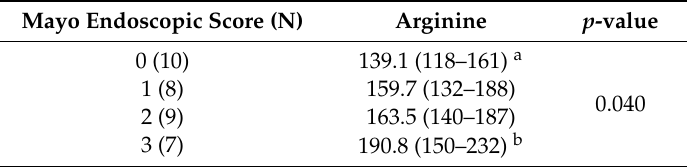
Table 3. Arginine association with Mayo endoscopic